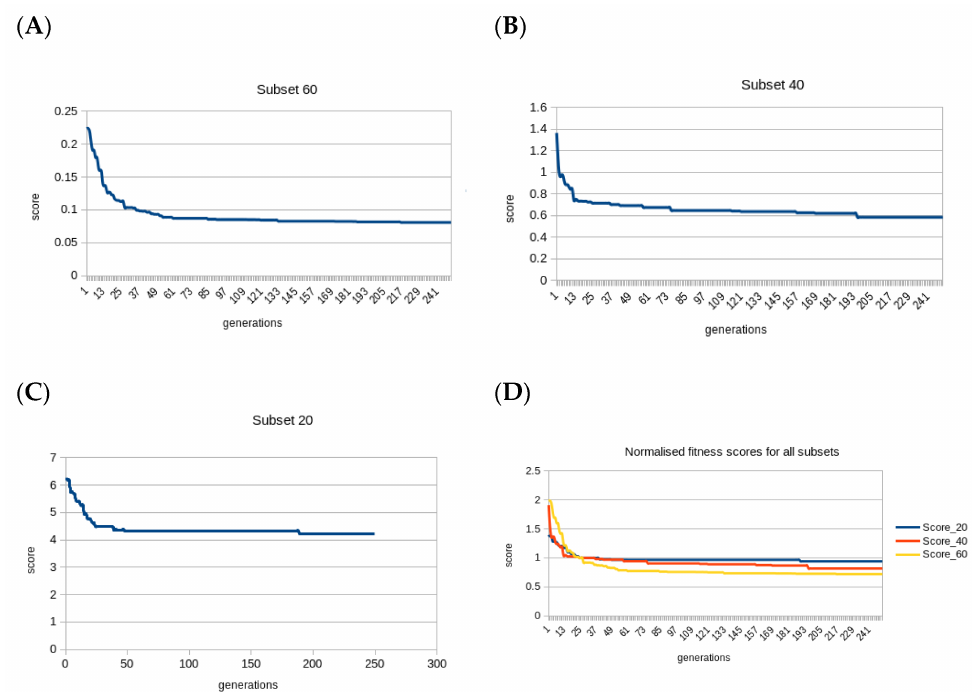
Figure 1. Learning curve (best score in each generation) of genetic algorithm (GA) feature selection with ( A ) 60 features ( B ) 40 features and ( C ) 20 features as the gene-set size to be optimized. Fitness function stabilizes gradually for all three subsets within 250 generations approximately. The fitness function scores were median normalized for the three subset sizes and show a very similar curve ( D